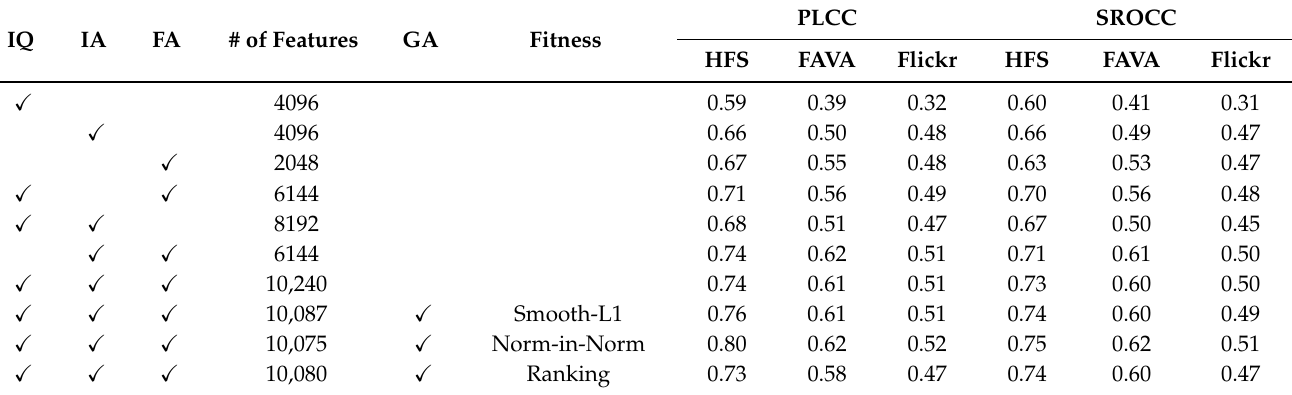
Table 4. PLCC and SROCC of the aesthetic quality prediction for each database by extracting perceptual features from the face